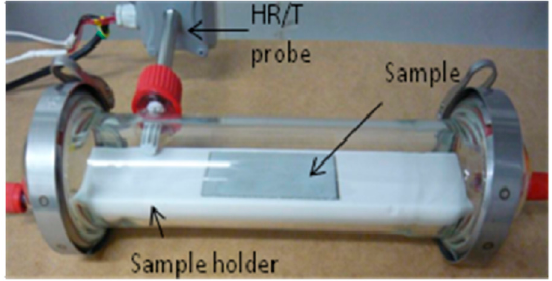
Figure 34. Cylindrical reactor (borosilicate-glass; dia. = 60 mm; length = 300 mm; high transparency to UV-A radiation; low adsorption capacity) used by Martinez and coworkers [125] to test the photocatalytic TiO 2 coatings toward the abatement of NO x pollutants; coated and control samples (100 × 50 mm 2 ) were placed in the median plane of the reactor using a PTFE holder; gas circulated through the semi-cylindrical space between test piece and upper part of the reactor. Light source was a 300-W OSRAM Ultravitalux bulb with an emission spectrum close to that of daylight (light intensity = 5.8 W m − 2 ). Other experimental conditions: flow rate, 1.5 L min − 1 ; initial NO concentrations, 400–2000 ppb; relative humidity, 0–74%; temperature, 25 °C). Reproduced with